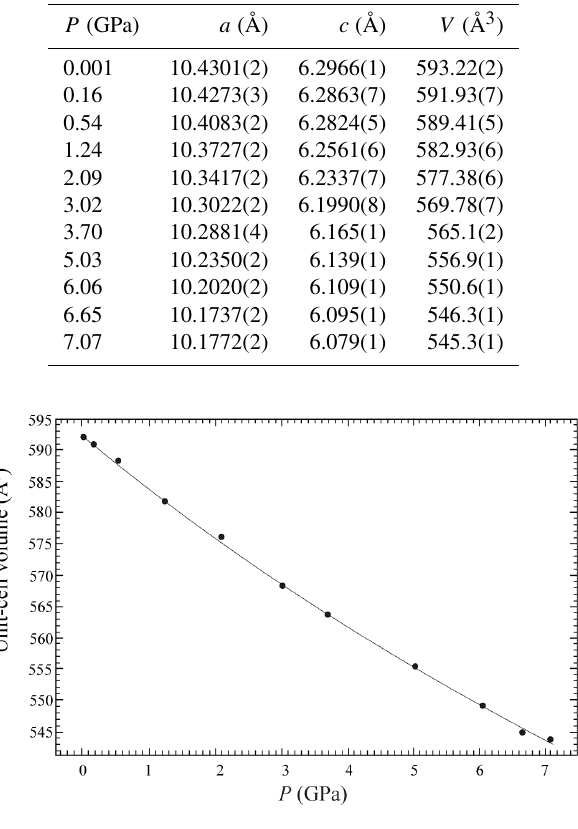
Figure 3. Evolution of the unit-cell volume with pressure of bur- bankite. The solid line represents the BM2-EoS